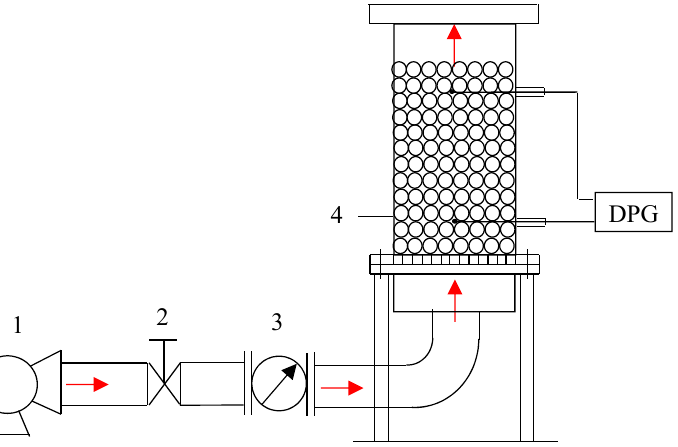
Figure 1. Structural diagram of the self-made experimental facility: (1) air blower; (2) throttle valve; (3) orifice plate flow meter; (4) experimental vertical tank. Table 1. Particle parameters and change in the ranges of the gas superficial